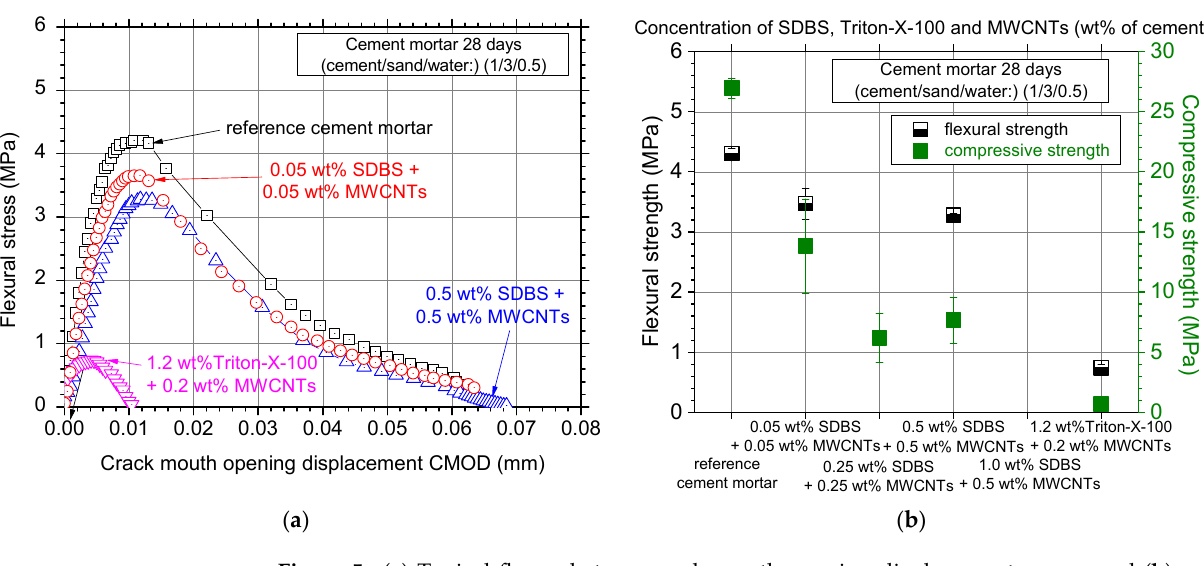
Figure 5. ( a ) Typical flexural stress–crack mouth opening displacement curves and ( b ) average flexural and compressive strength values and standard deviation of the nanocomposites dispersed with the SDBS and Triton X ‐ 100 surfactants.